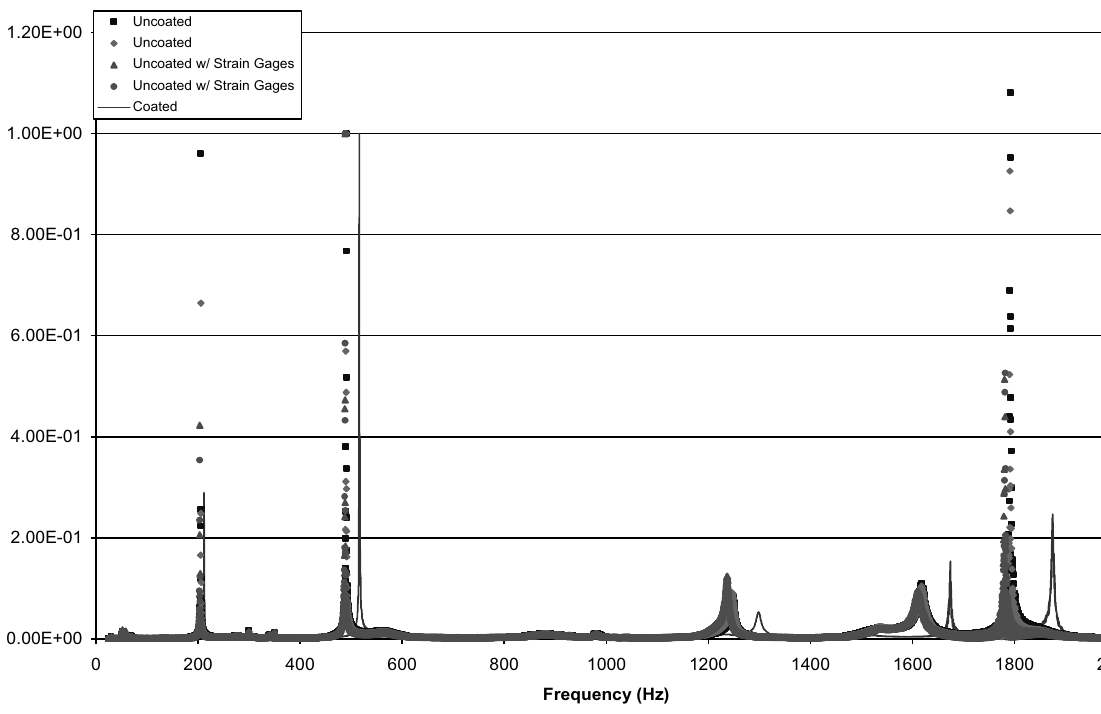
Fig. 5. Frequency response from laser vibrometer for plate T1. (Uncoated with and without strain gages and